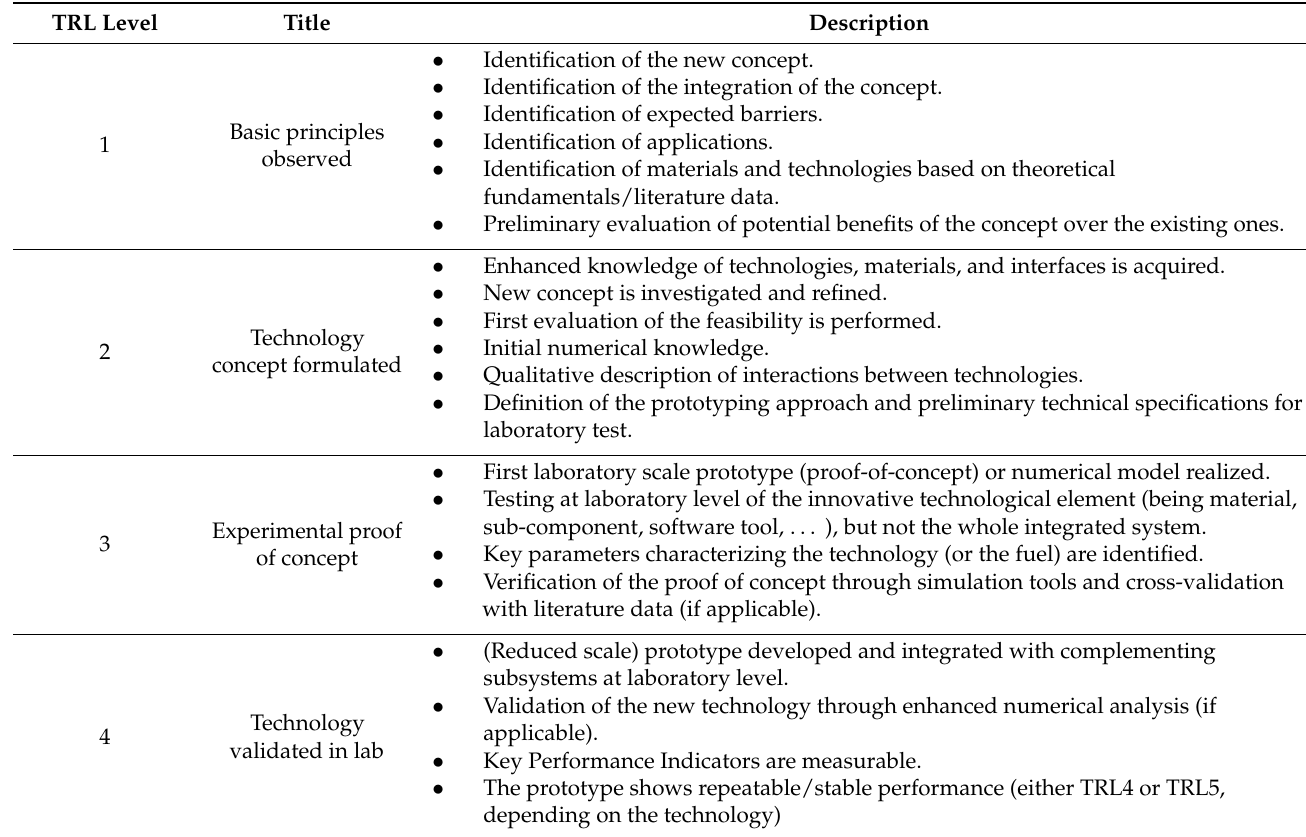
Table A1. Technology Readiness Level scale